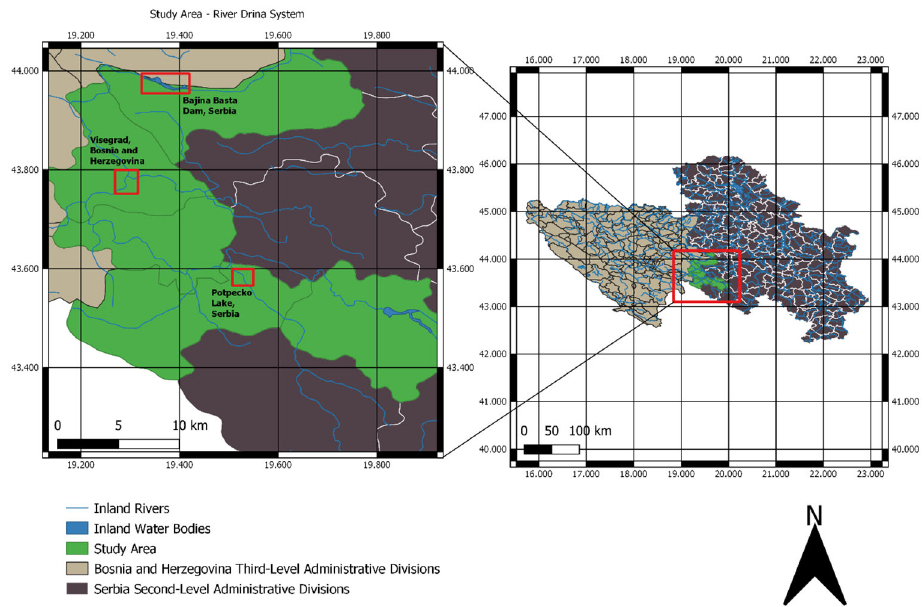
Figure 1. ( Right ) Map of Bosnia and Herzegovina and Serbia with overall study area highlighted. ( Left ) Focussed map of study area with three locations of interest highlighted. Data of land borders from Hijmans, J and University of California, Berkeley. Museum of Vertebrate Zoology (https://geodata.lib.utexas.edu/catalog/stanford-xt594tq5034) (accessed on 12 August 2022) [42]. Data of inland rivers and water bodies from Hijmans, J, DIVA-GIS. (Download data by country|DIVA-GIS) (accessed on 12 August 2022) [43].